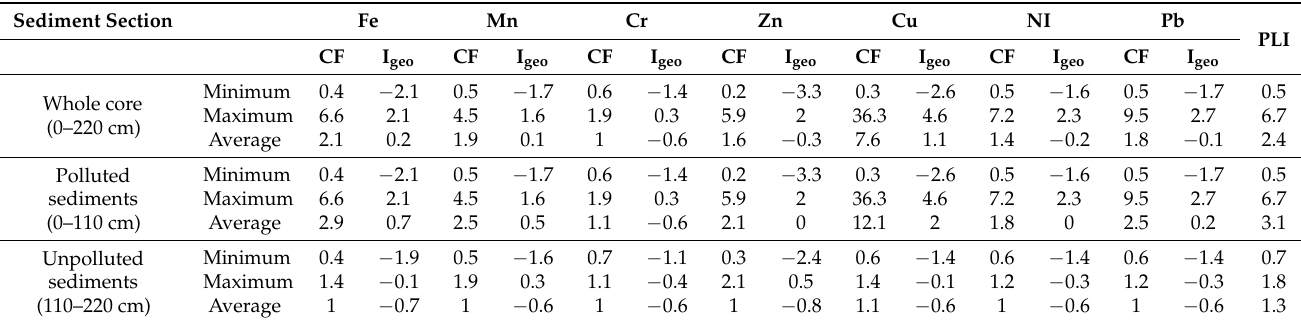
Table 3. Contamination factor (CF), geo-accumulation index (I geo ), and pollution load index (PLI) for the core sediments (Salam1) from the Al-Salam Lagoon, Jeddah coast. Average values for whole core (0–220 cm), polluted sediments (0–110 cm), and unpolluted sediments (110–220